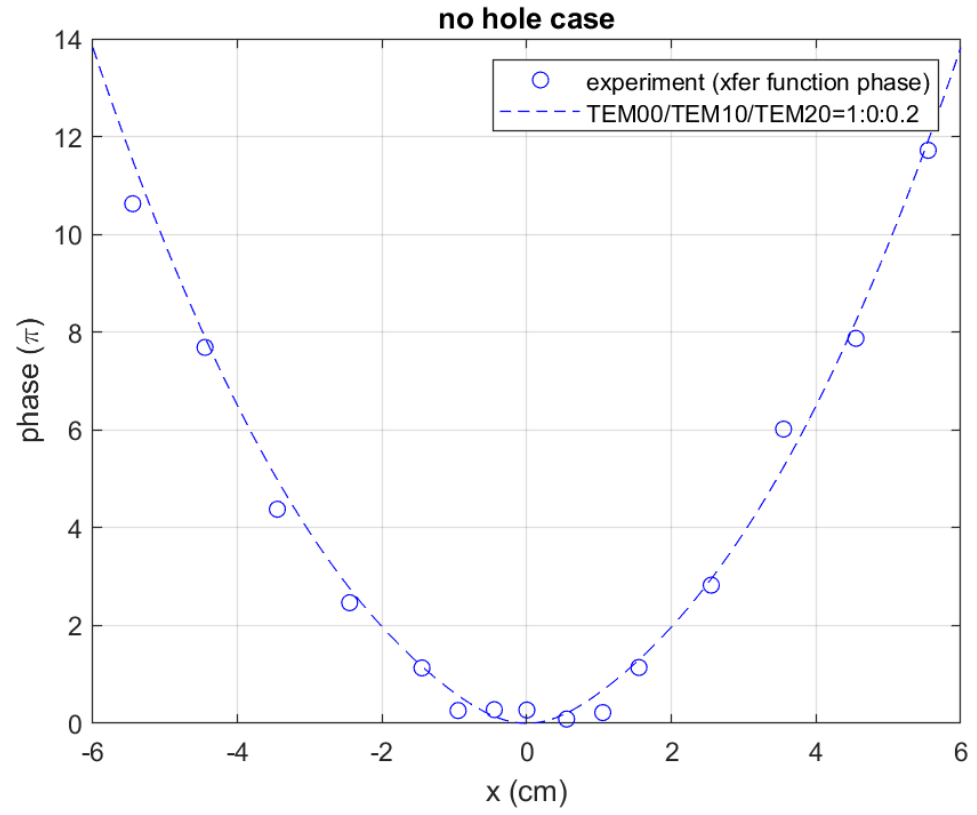
Figure 13. Experimental and theoretical phase as a function of x